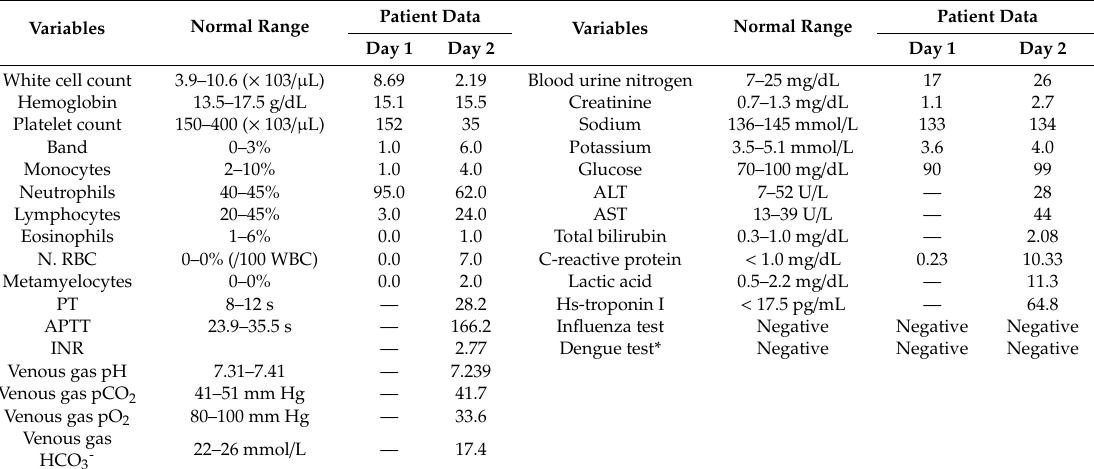
Table 1. The laboratory evaluation of this